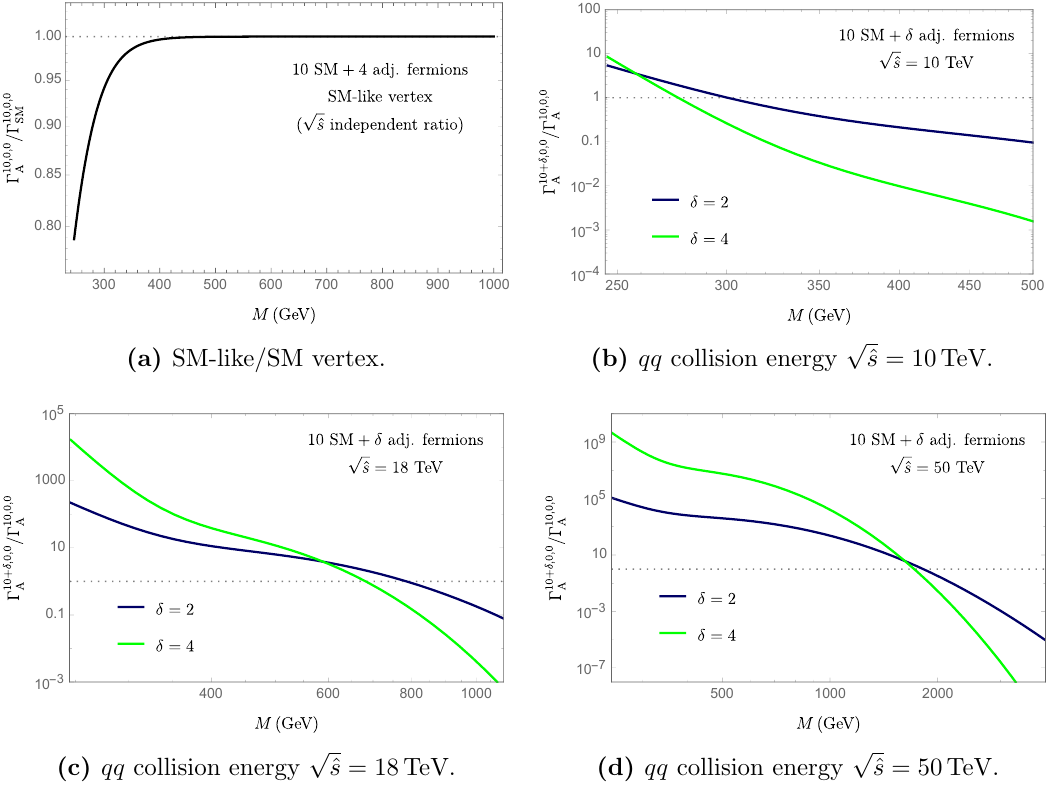
Figure 2. SM-like/SM (upper left) and BSM/SM-like rate ratios for up to four additional heavy mass fermions in the adjoint representation of